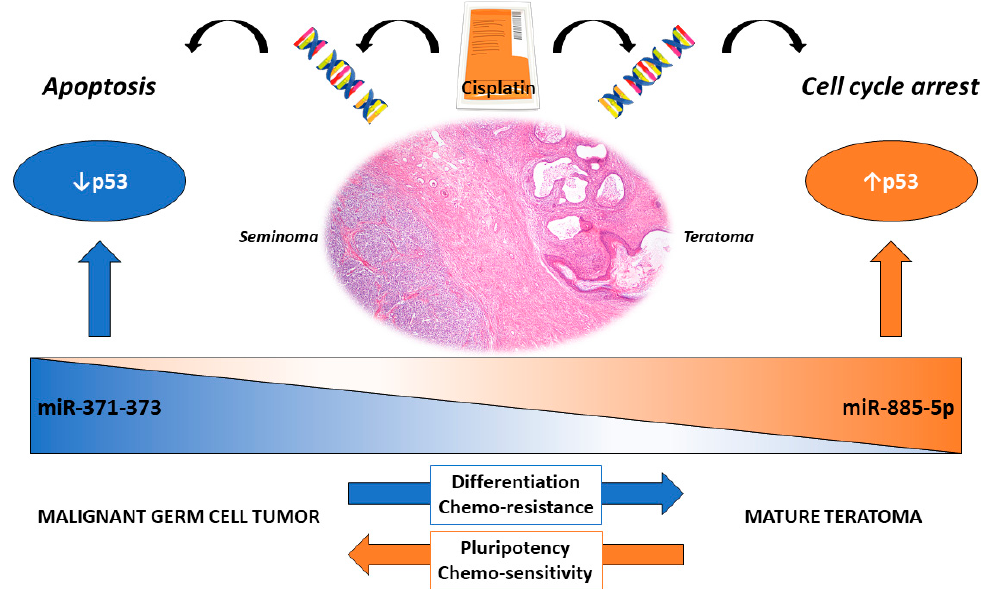
Figure 3. The proposed “microRNA switch” occurring in testicular germ cell tumors related to differentiation. MicroRNAs of the 371–373 cluster are upregulated in malignant subtypes (here represented by a seminoma histology) and target p53 (there are hardly any TP53 mutations in these tumors). The response to cisplatin is a proapoptotic response. In differentiated mature teratoma, on the contrary, this cluster is negative, and miR-885-5p is upregulated. The latter is a p53 activator. The response to cisplatin is directed towards cell cycle arrest, hence the clinical cisplatin resistance.